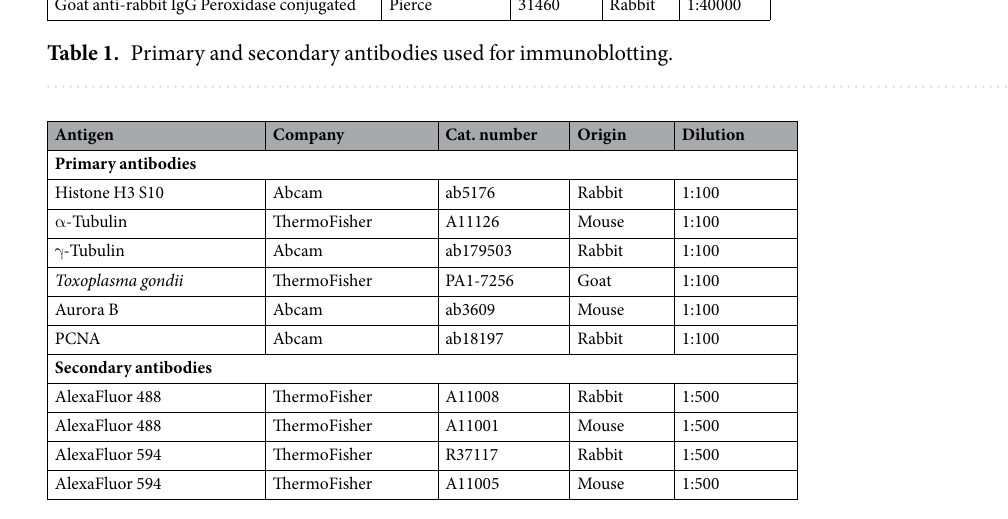
Table 2. Primary and secondary antibodies used for immunofluorescence